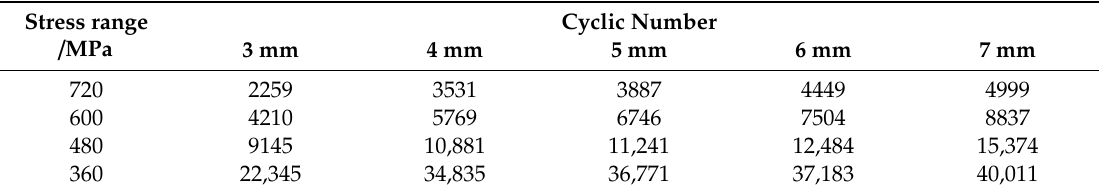
Table 6. The life of steel wire with semi-ellipsoidal notches of different widths. Stress range / MPa